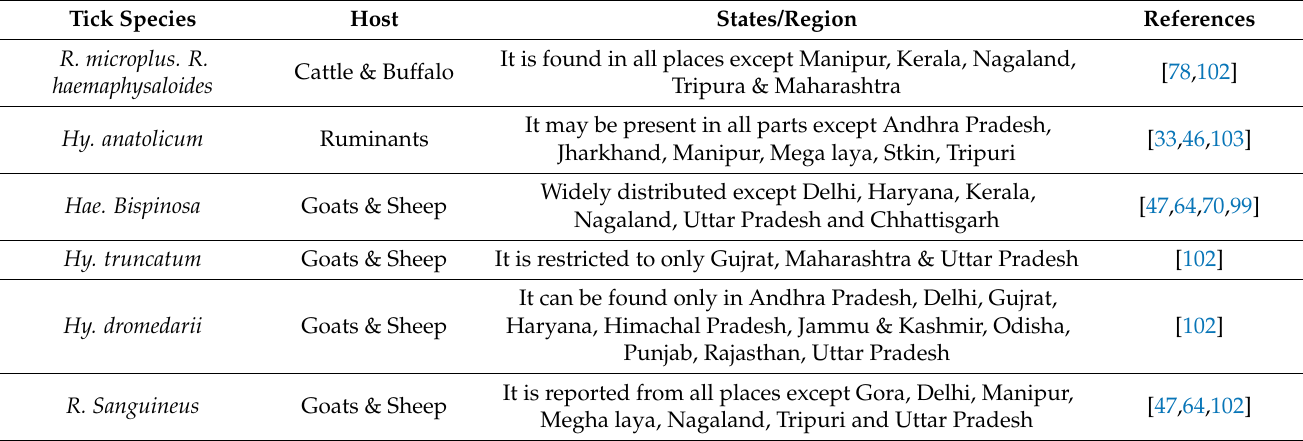
Table 3. Distribution of the possible vector tick species of Theileria in different regions of